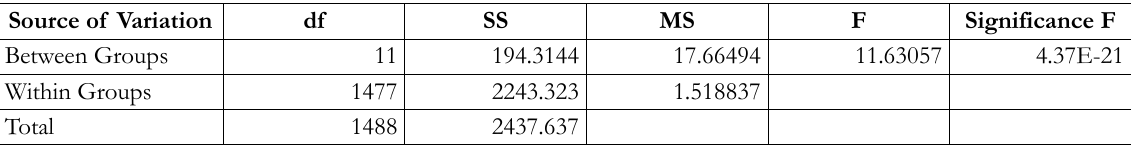
Table 21. Anova Table for Barrier